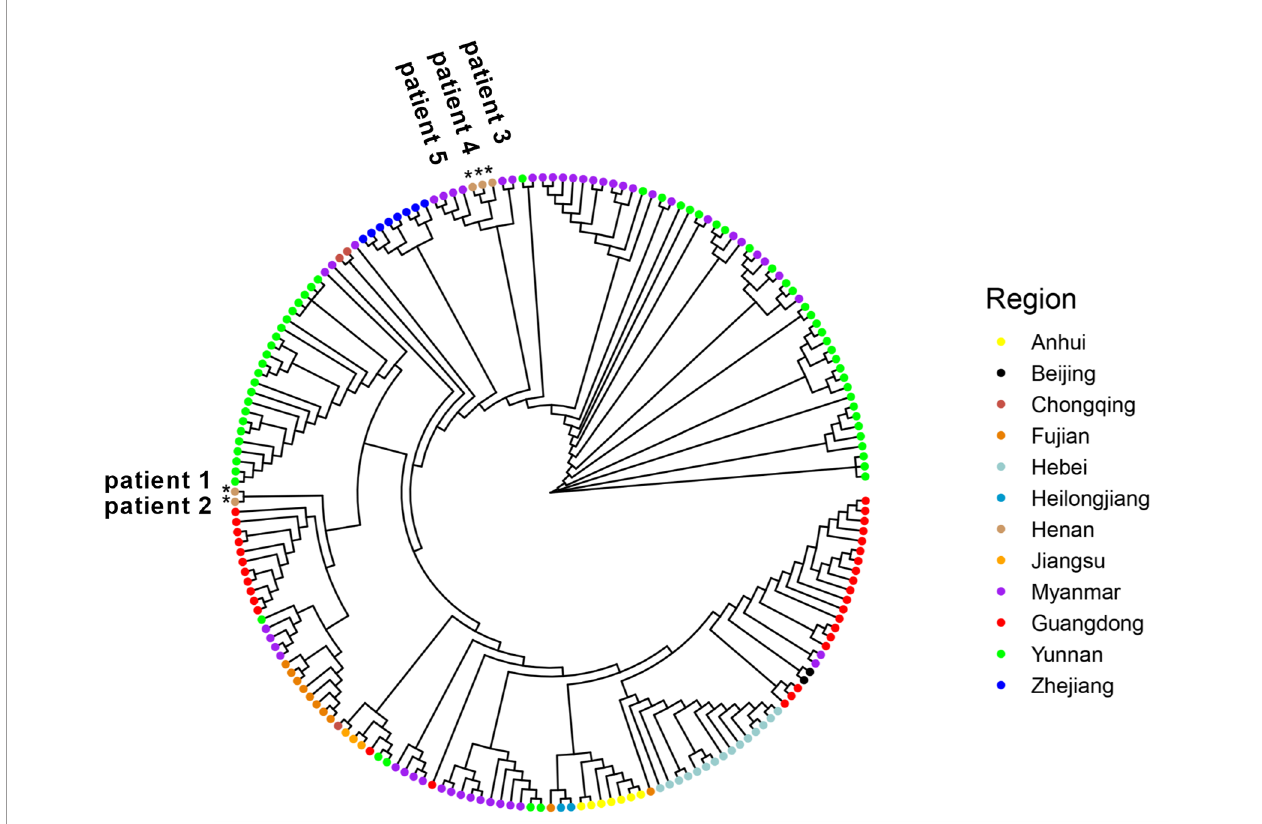
FIGURE 5 | Five genome sequences in this study were aligned with 141 genomes from other provinces of China. In addition, 48 sequences from Myanmar were also added. All sequences were selected from January through November 2021 and downloaded from GISAID. Samples in this study were labelled as